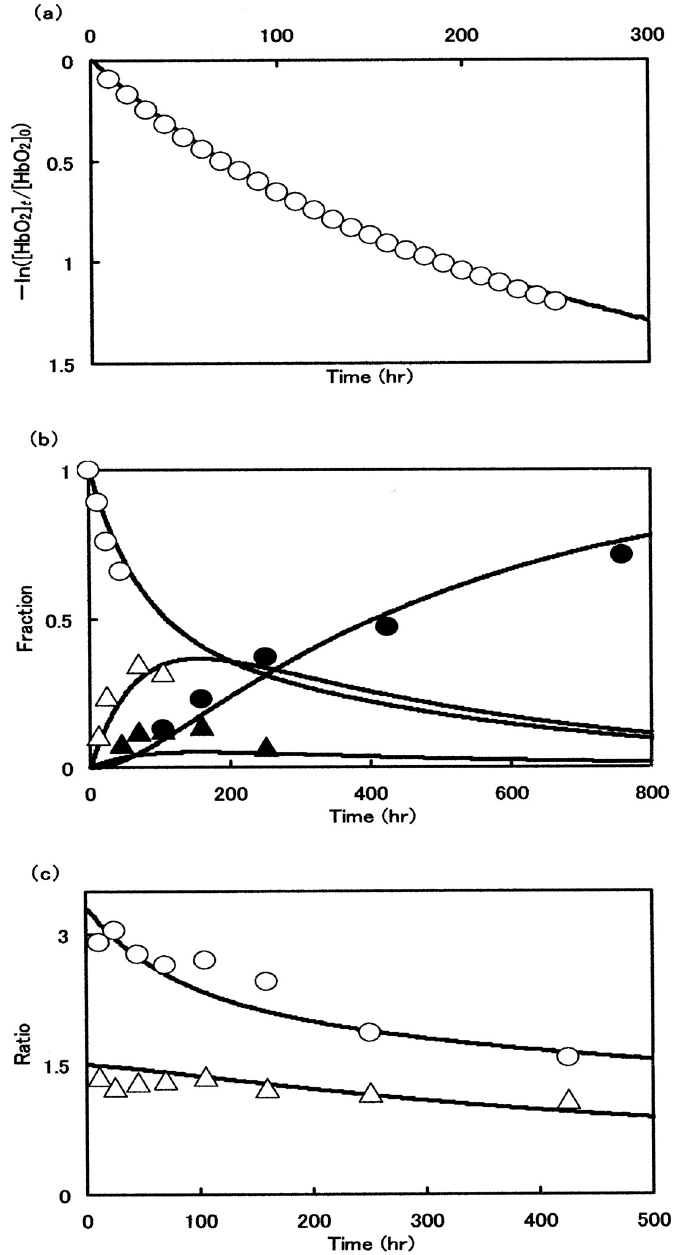
Figure 13. Outcomes achieved by a computer simulation using the consecutive reaction f and k s for human HbO model with k autoxidation. ( a ) The –ln([HbO ] /[HbO ] ) versus A A 2 2 t 2 0 time plot; ( b ) isoelectric-focusing electrophoretic profiles; and ( c ) polyacrylamide gel electrophoretic profiles. Solid lines represent the curves derived from the Runge–Kutta f = 0.148 h –1 , k s = 0.0208 h –1 and method with setting of the following constants: k A A Δ t = 0.1 h. For (b), the symbols are designated as follows: the 1st ( ○ ), 2nd ( △ ), 3rd ( ▲ ) and 4th peaks ( ● ),